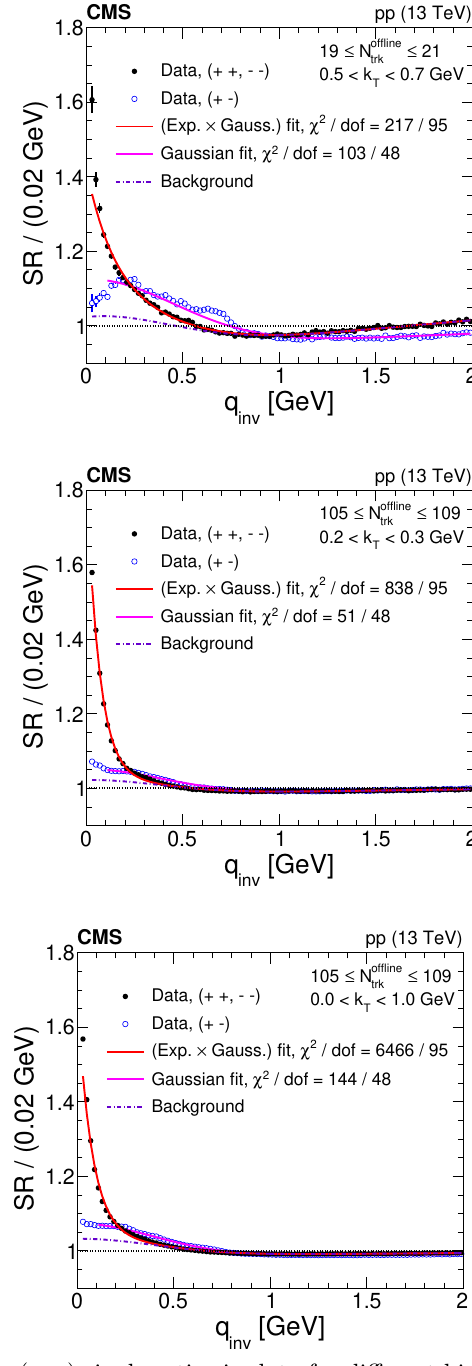
Figure 3 . The same-sign (++ ; (cid:0)(cid:0) ) and opposite-sign (+ (cid:0) ) single ratios in data for di(cid:11)erent bins of N o(cid:15)ine and k , with their respective (cid:12)ts. The label \(Exp. (cid:2) Gauss.) (cid:12)t" refers to the same- trk T sign data and is given by eq. (5.7). The label \Gaussian (cid:12)t" corresponds to eq. (5.4) applied to opposite-sign data and \Background" is the component of eq. (5.7) that is found from the Gaussian (cid:12)t using eqs. (5.5) and (5.6) to convert the (cid:12)t parameters. Coulomb corrections are accounted for using the Gamow factor. The error bars represent statistical uncertainties and in most cases are smaller than the marker